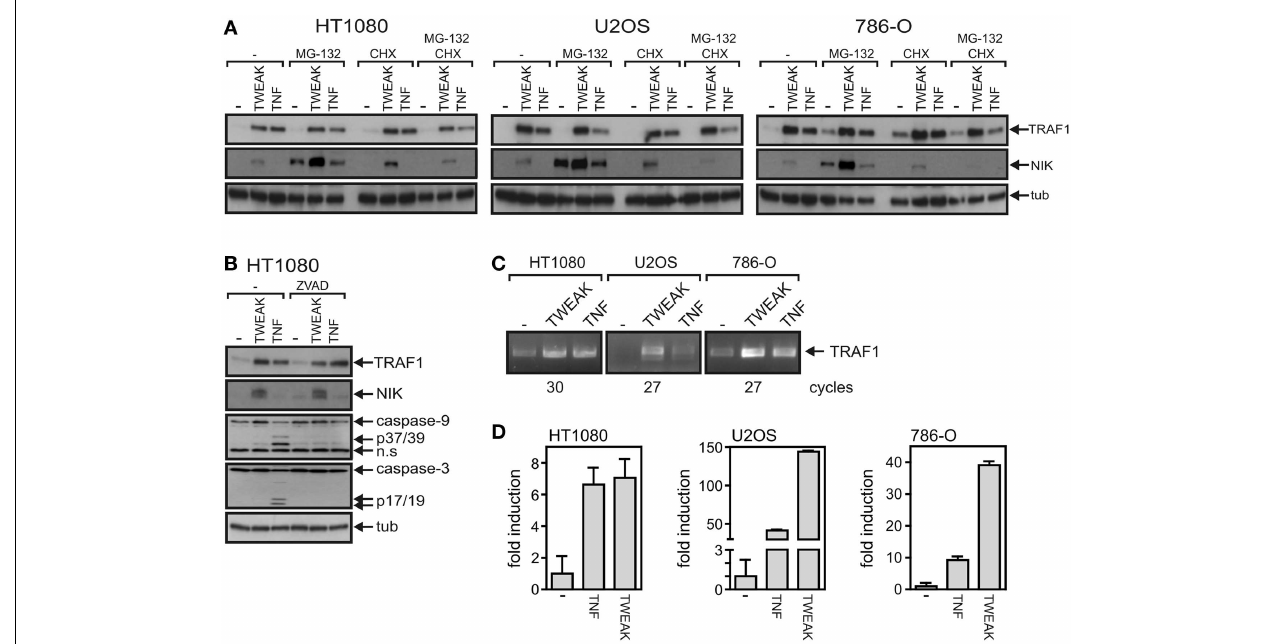
absence of z-VAD-fmk (20 µ M) and total cell lysates were analyzed by western blotting forTRAF1 induction. (C,D) Total RNA was isolated from cells stimulated with Flag-TNF (100ng/ml) or Flag-TWEAK (200ng/ml) overnight and subjected to analysis by reverse transcriptase PCR (C) and quantitative real time PCR.The average fold induction calculated from normalized data derived of three fully independent experiments is shown (D)